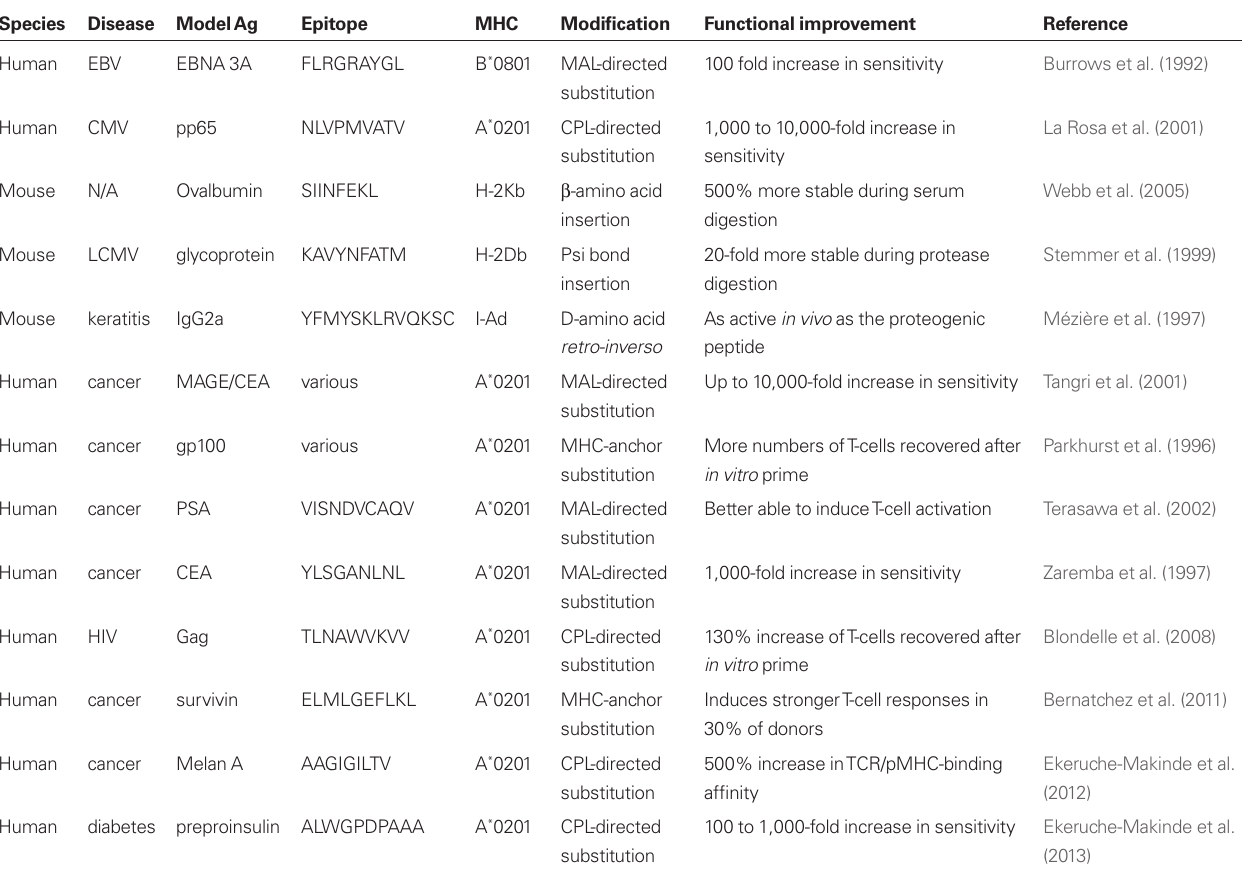
Table 1 | Examples of T-cell epitope optimization. Species Disease Model